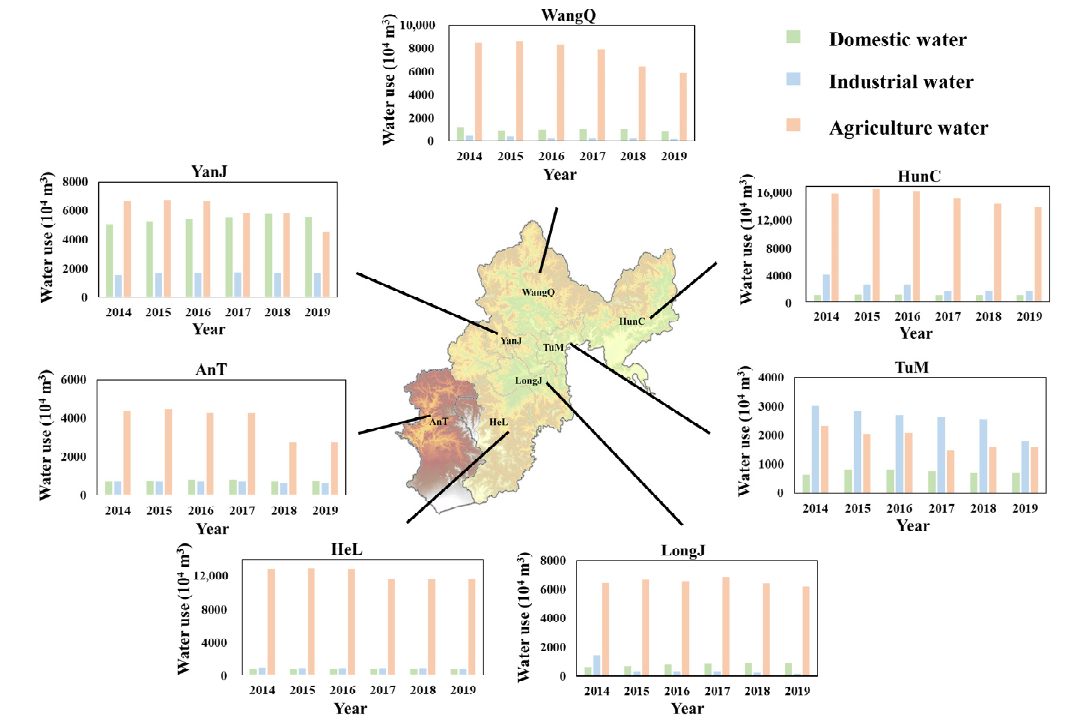
Figure 2. Analysis of water use in the TRB from 2014 to 2019.